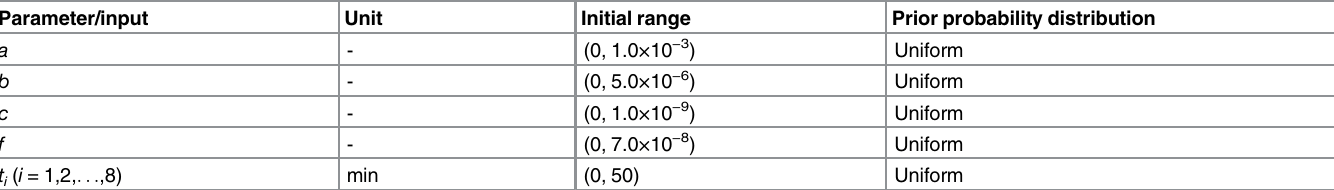
Table 1. Initial ranges and probability distributions of model parameters and